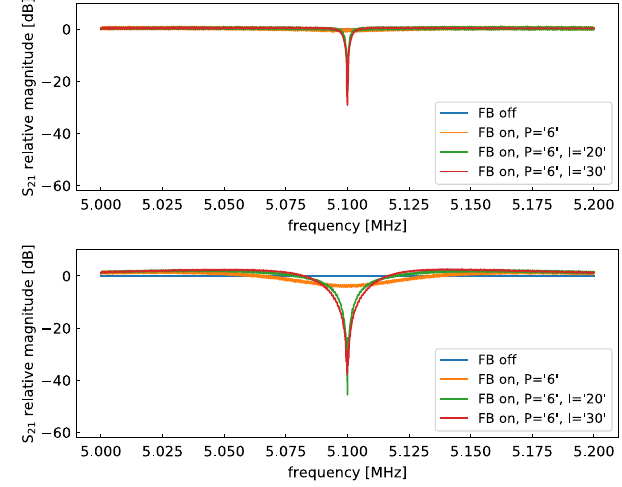
FIG. 22. Normalized closed loop gains with various PI gain settings at 5.1 MHz, in the cases of (top) the constant gain LUT and (bottom) the gain LUT